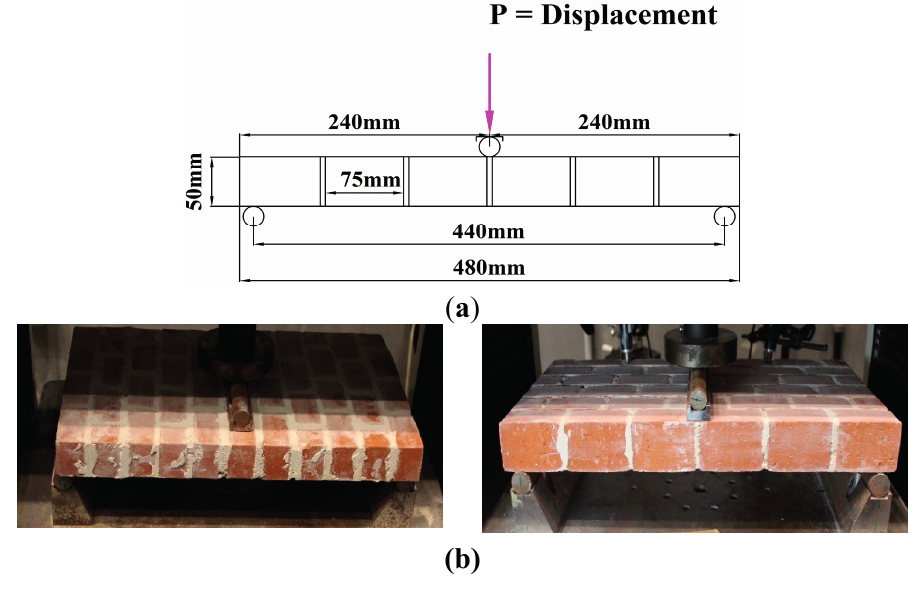
Figure 13. Test setups of masonry panels under out-of-plane bending test: ( a ) schematic and ( b ) experimental.